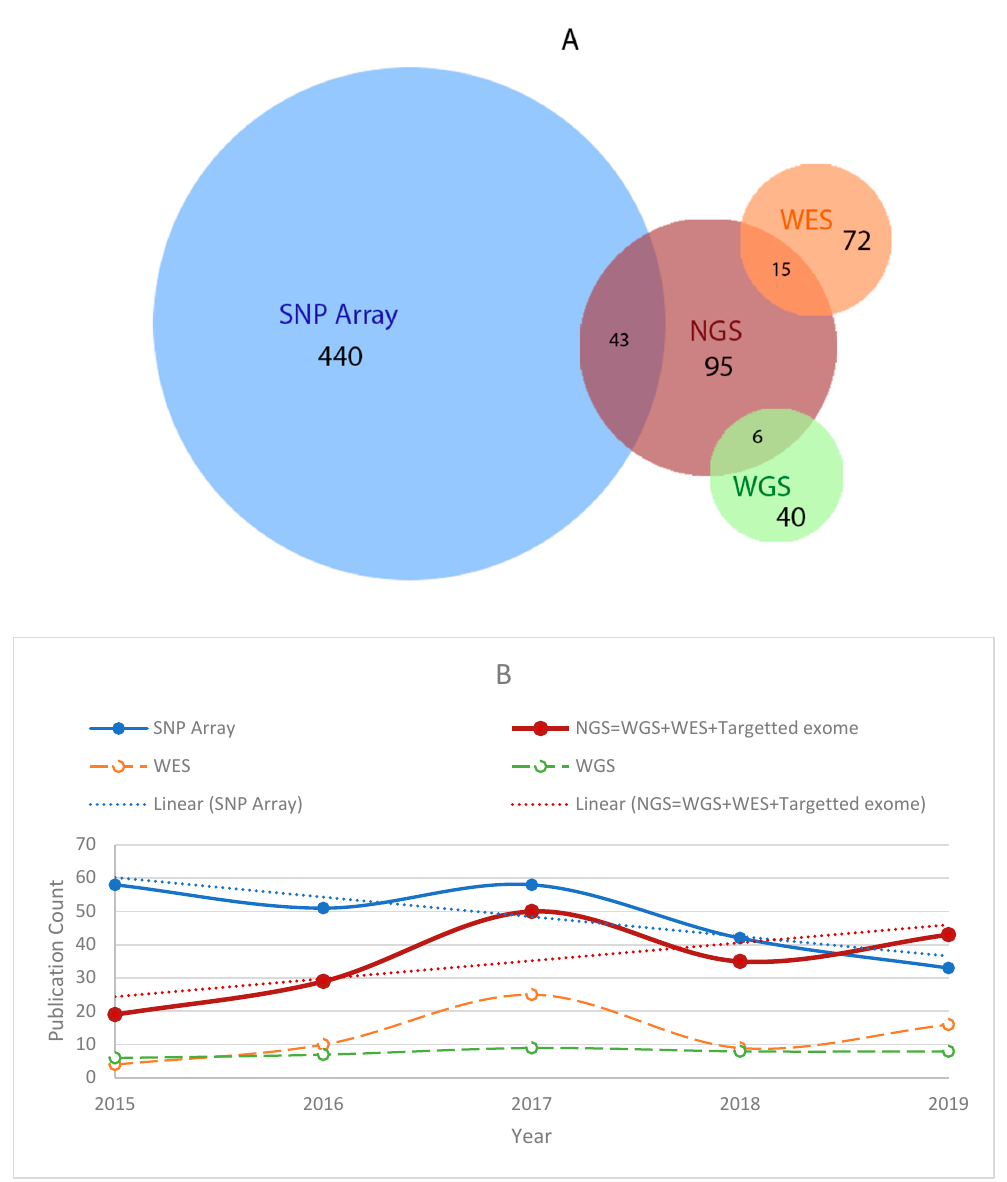
Figure 3. A comparative view of the usage of a SNP array and sequencing technology to study genetic modifiers. ( A ) Publication count between the years 1998–2019. ( B ) Recent (2015–2019) publications indicate increased interest in high throughput sequencing techniques. Two linear (dotted) lines are used to show the trend shift.